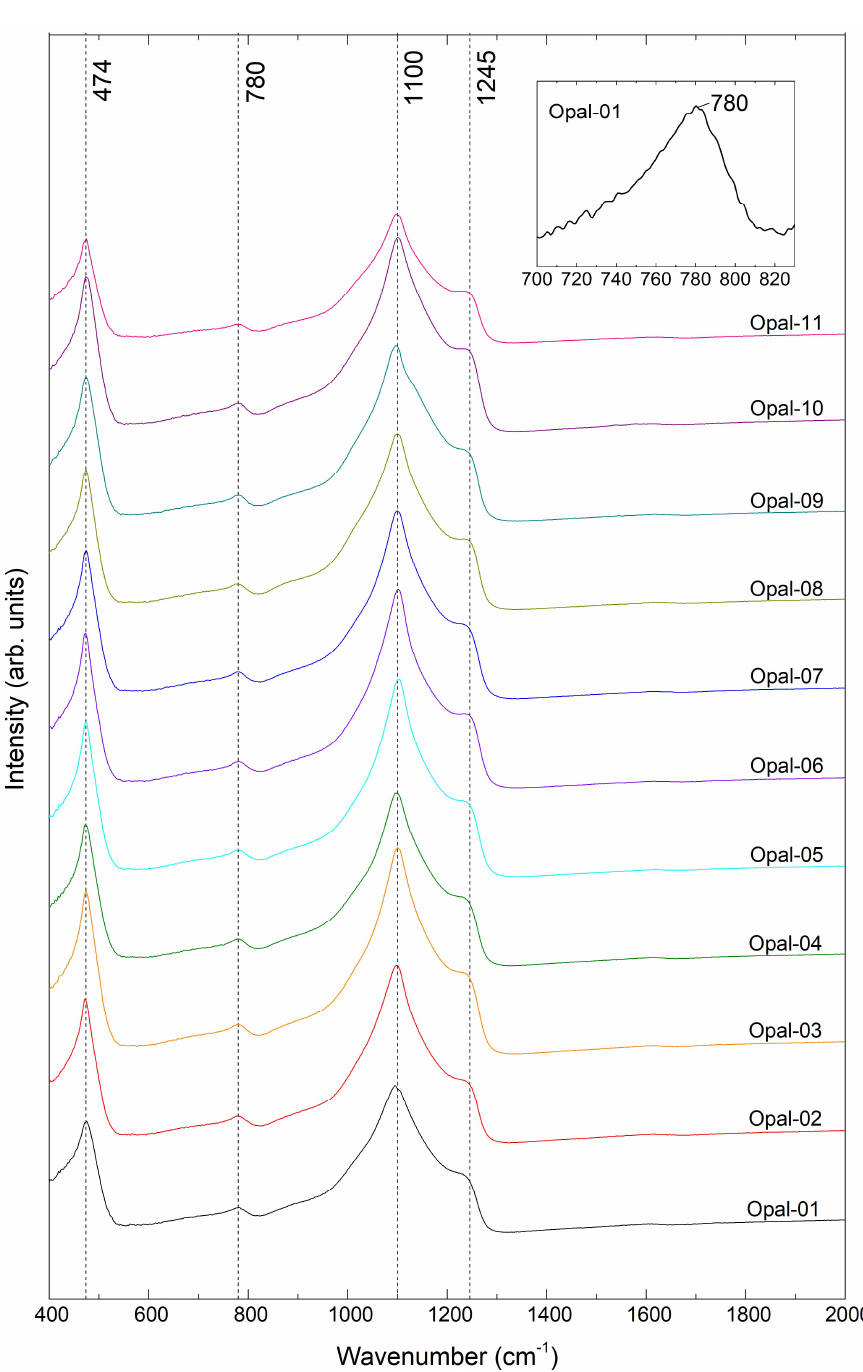
Figure 8. Infrared spectra of all 11 samples, with three bands around 474, 780 and 1100 cm −1 , and an inflexion point at 1245 cm −1 .